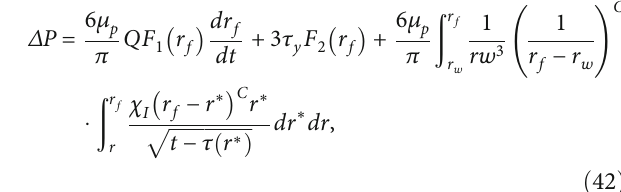
ð 42 Þ ð r Þ 1 f